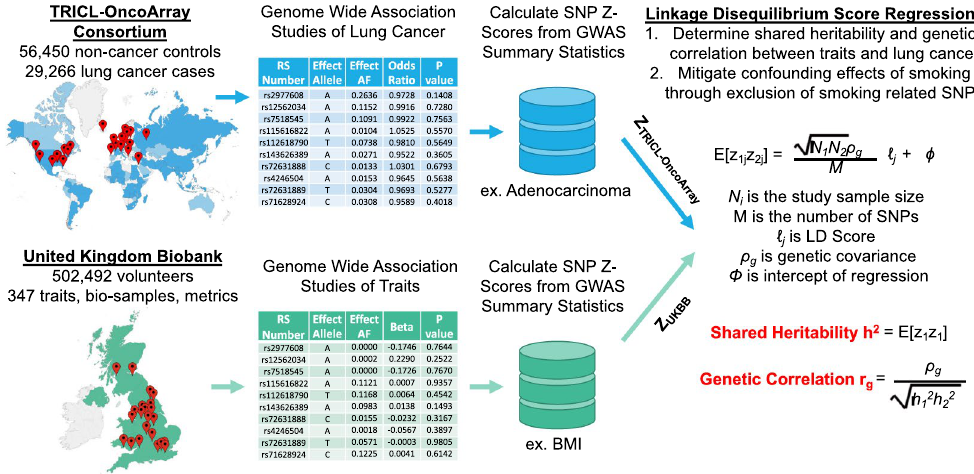
Figure 1. Graphical representation of the analytical workflow, including datasets utilized and analyses performed. Maps rendered with Tableau Desktop, 2021 Tableau Software, LLC, https:// www. table au. com/.